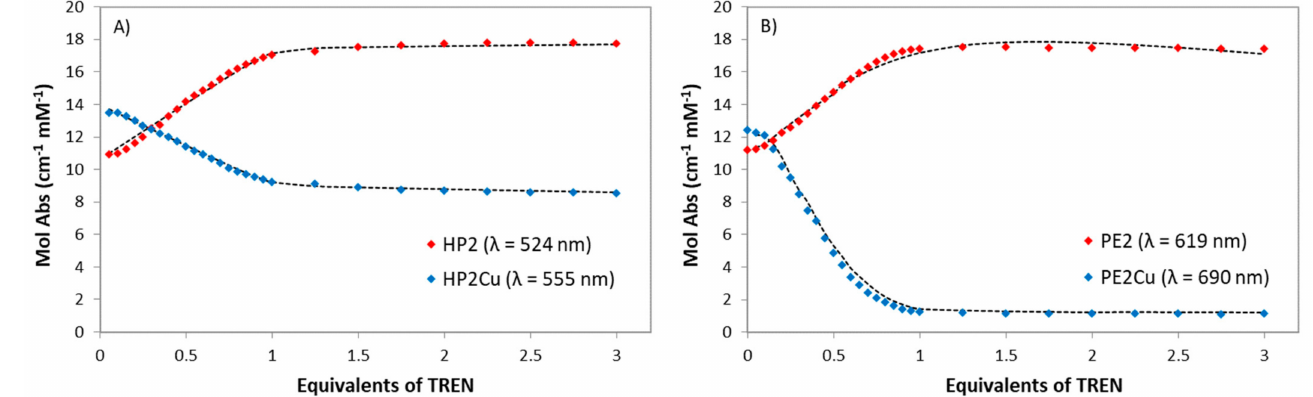
Figure 3. Spectrophotometric competitive titration of Cu(II)-NDI complexes with TREN. Here we reported the distribution diagrams of the species for the titrations of ( A ) HP2Cu and ( B ) PE2Cu with increasing equivalents of TREN in 0.1M HEPES buffer, pH 7.4, 25 ◦ C.